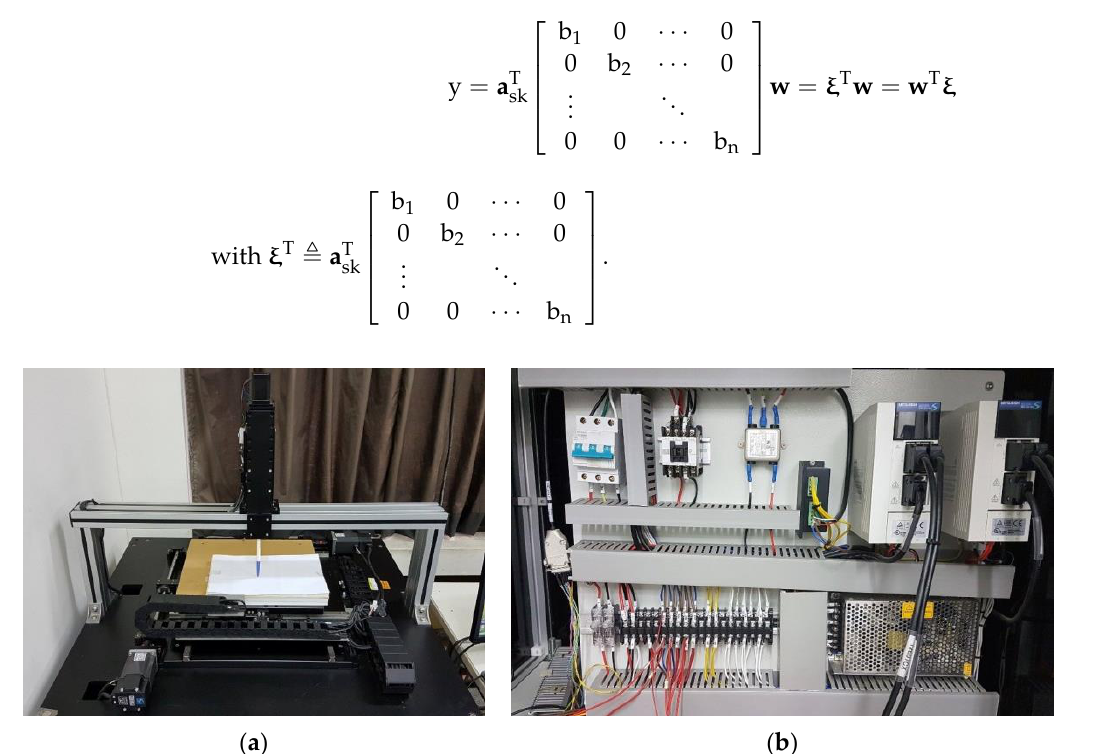
Figure 1. ( a ) Photographs of the two-axis motion stage, and ( b ) the servo drive system.